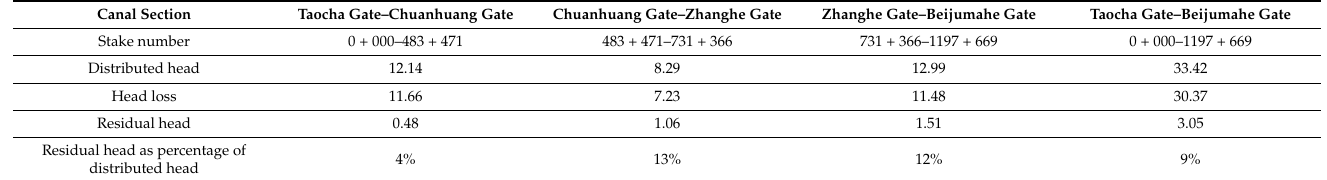
Figure 6. Distributed heads and residual heads of 143 crossing structures in the Main Canal. Table 4. Head loss and residual head of crossing water-conveyance structures by canal section (unit: m).